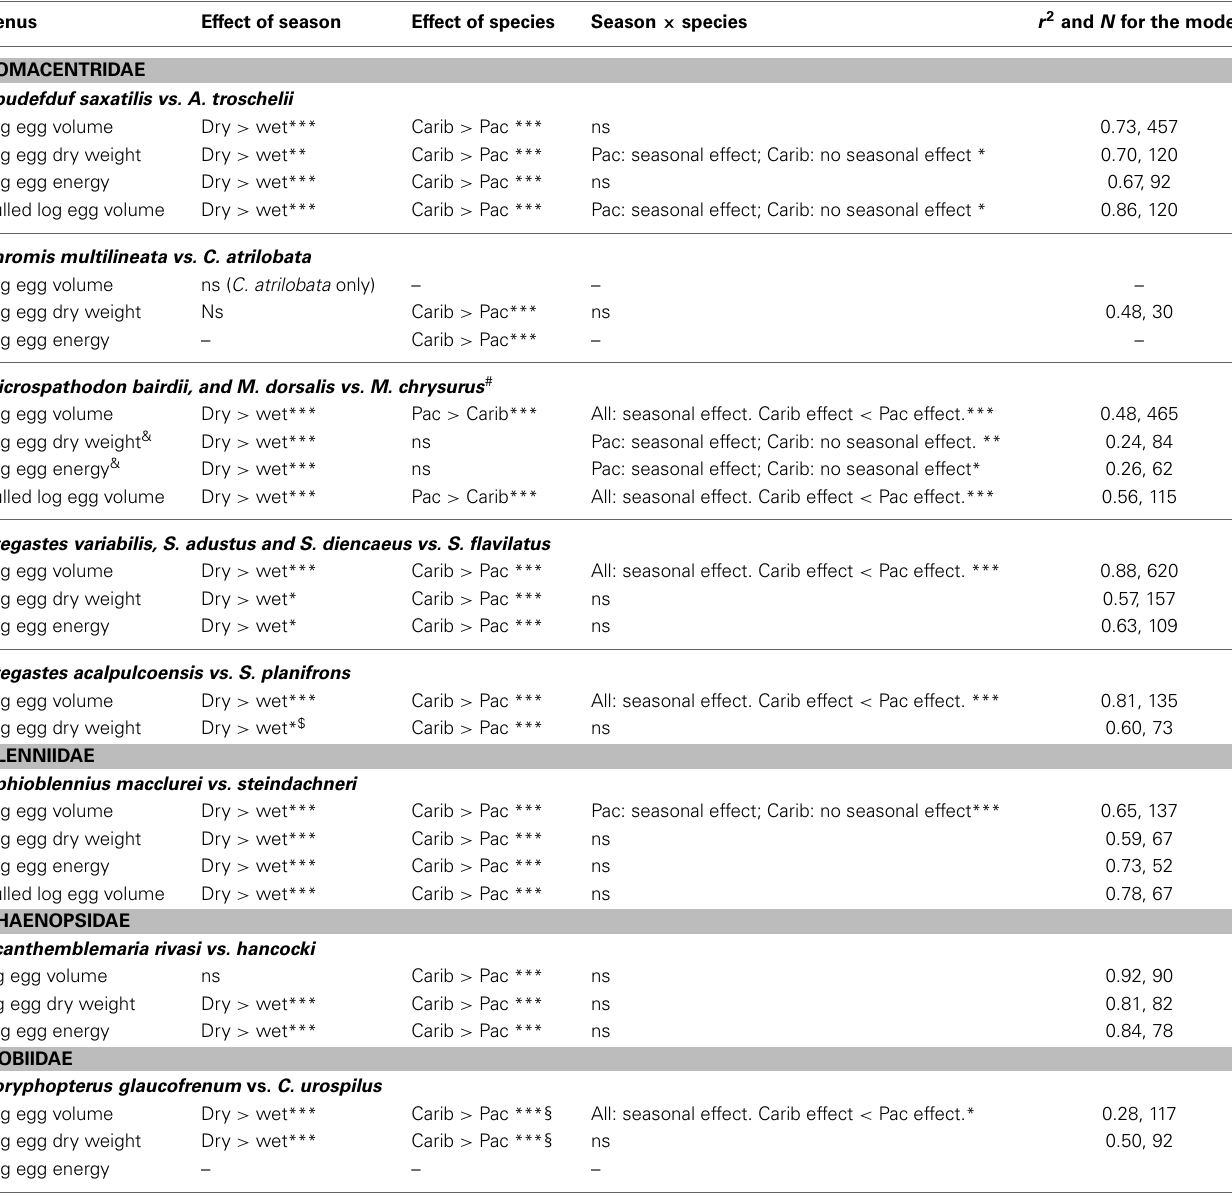
Table 3 | Results of the Two-Way ANOVA of 3 different measurements of egg size.